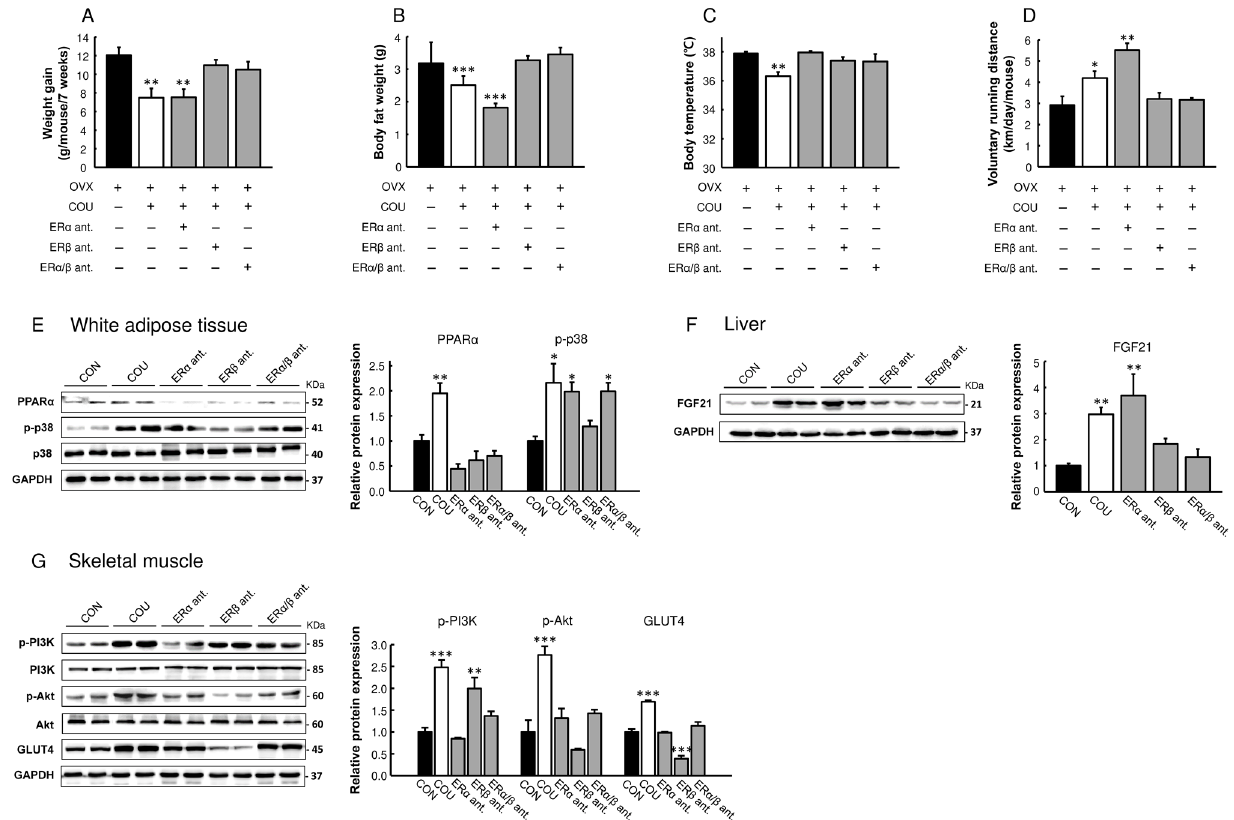
Figure 6. ER-mediated actions of coumestrol in the regulation of energy homeostasis. OVX mice were orally administered with 10 mg/kg coumestrol in combination with MPP (ER α -selective antagonist), PHTPP (ER β -selective antagonist), or ICI 182,780 (ER antagonist) for 7 weeks. ( A ) Weight gain and ( B ) body fat weight. ( C ) Body temperature was measured in the ear using an infrared thermometer 4 weeks after ovariectomy. ( D ) Voluntary running distance was recorded 6 weeks after surgery. Protein expression of ( E ) PPAR α , p-p38, and p38 in white adipose tissue, ( F ) FGF21 in the liver, and ( G ) p-PI3K, PI3K, p-Akt, Akt, and GLUT4 in skeletal muscle were measured by Western blotting. Values represent means ± SEM ( n = 6 for A-D, n = 4 for E-G). CON, control; COU, coumestrol; ER α ant., ER α -selective antagonist; ER β ant., ER β -selective antagonist; ER α / β ant., ER α / β antagonist; OVX, ovariectomized; GAPDH, glyceraldehyde-3-phosphate dehydrogenase; KDa, kilodaltons. * Significantly different from the OVX control group (* p < 0.05, ** p < 0.01, *** p < 0.001).